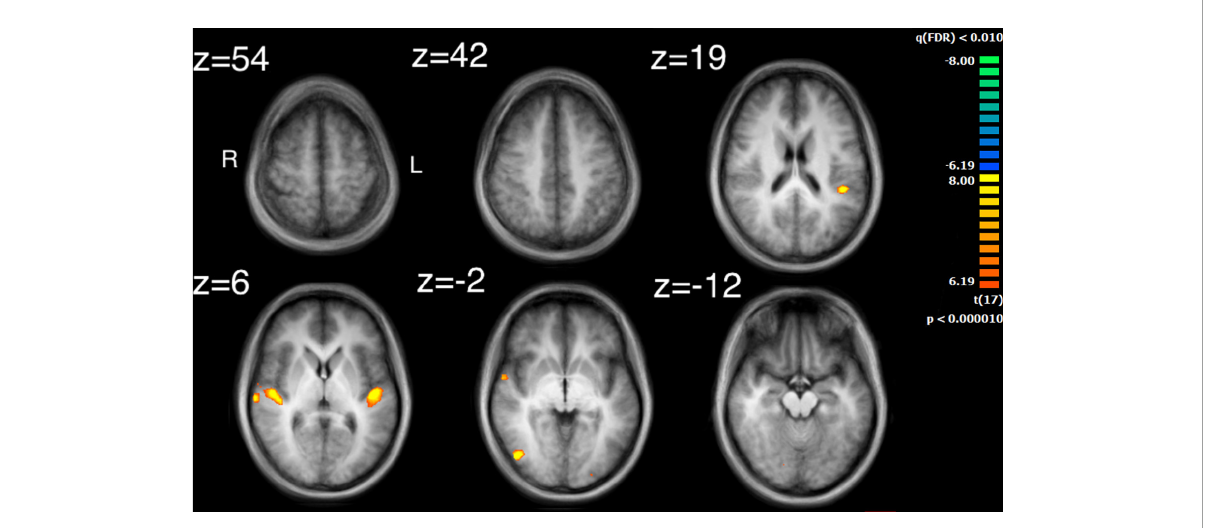
FIGURE3 Activity for the median values of SCG. Significant regions of activity include the left and right superior temporal gyrus, left inferior occipital gyrus and right inferior temporal gyrus.